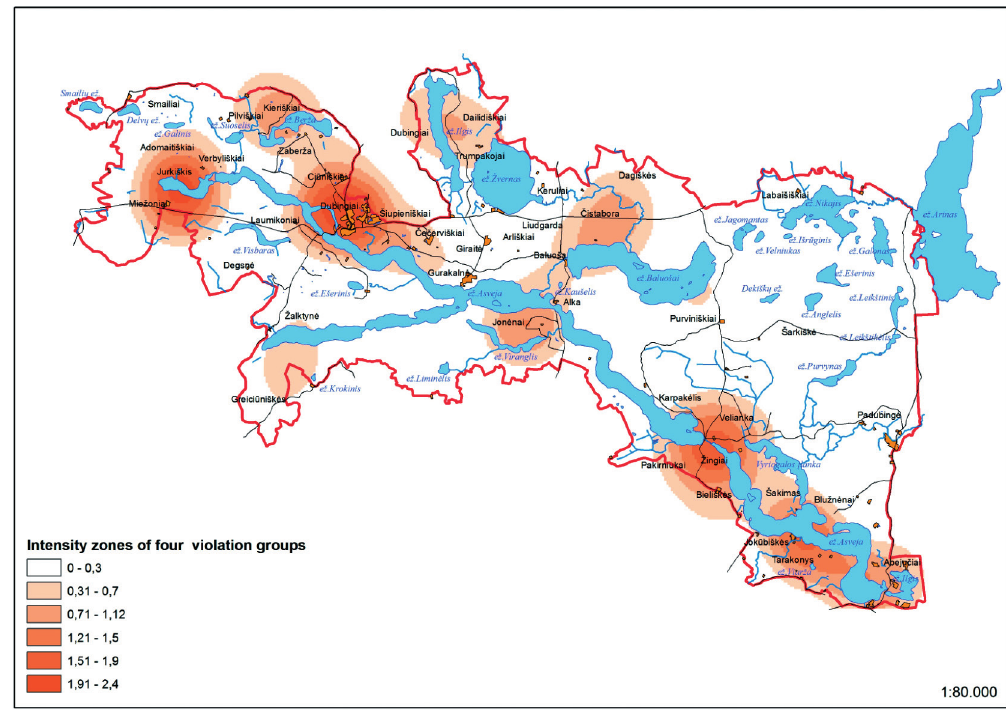
Fig. 2. Map of intensity zones of four violation groups (landscape, forests, constructional, water)